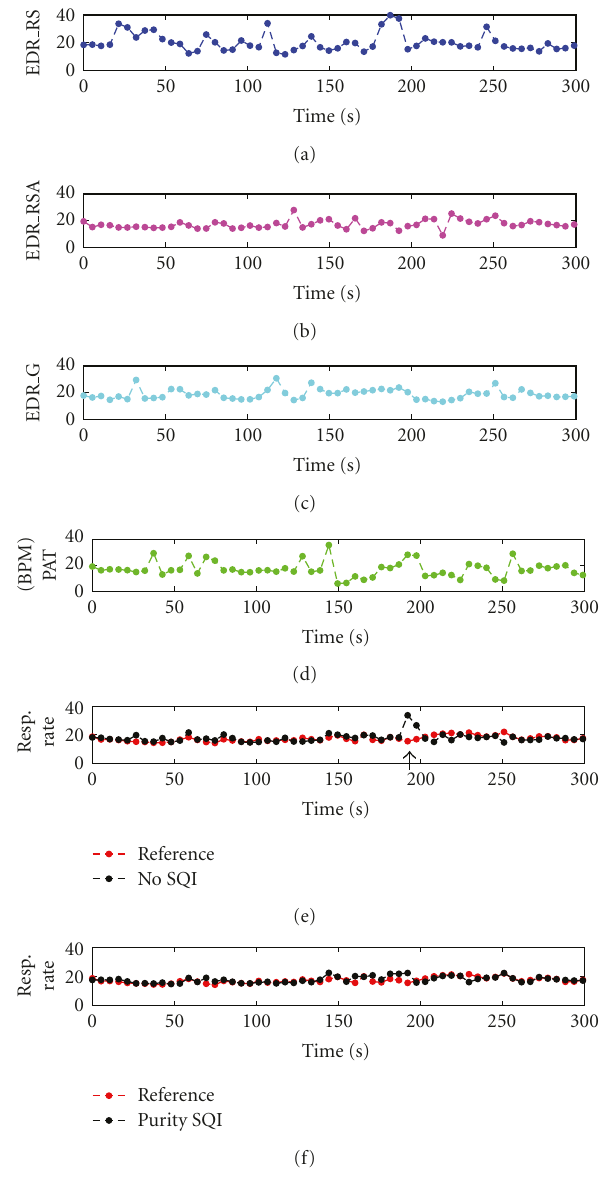
Figure 4: An example of the KF-based fusion method. From top to bottom: respiration rates derived from RS, RSA, QRS area, and PAT- based reparation waveforms, and the KF fusion results (black color) with no signal quality (fusion 0; 5th panel) and with the purity signal quality (fusion 2; 6th panel). The reference respiration rate is superimposed for comparison (red color). Clearly, inclusion of the signal quality improved fusion performance in the regions of poor signal quality (indicated by a black